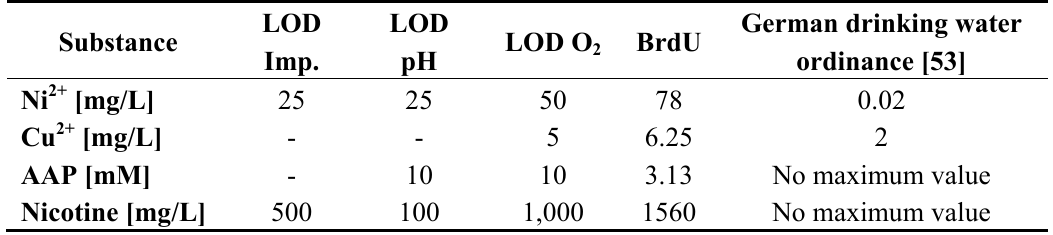
Table 3. Limit of detection (LOD) of the tested substances (Ni, Cu, AAP, nicotine) after the treatment of L6 cells for 15